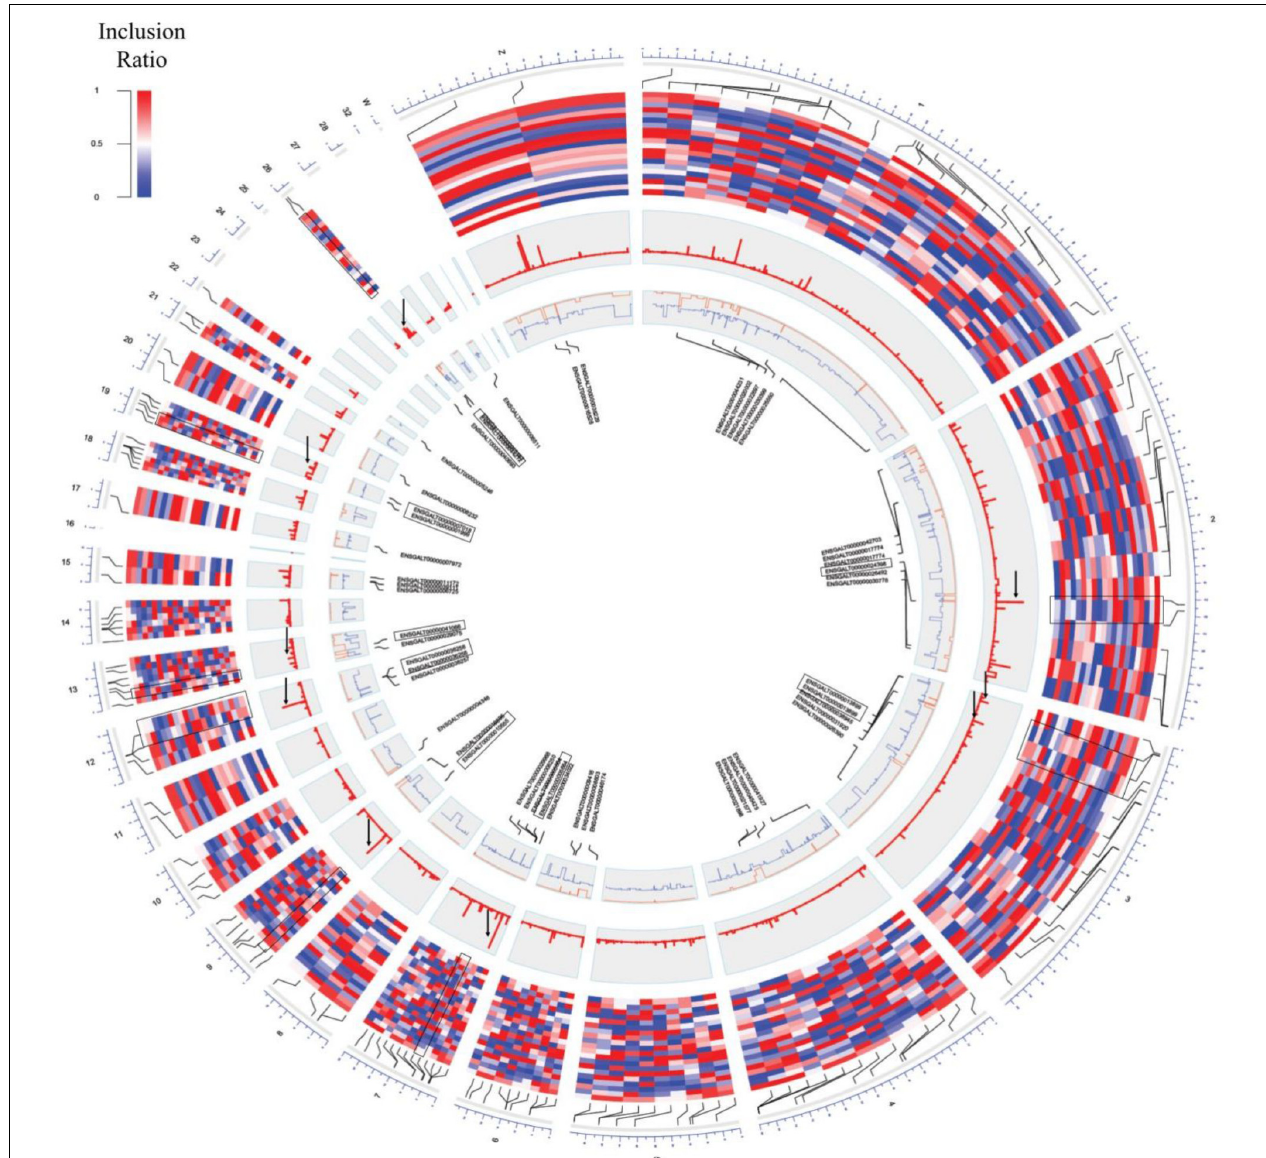
FIGURE 3 | Circos plot of switch-like exons. From the outer circle to inner circle are the genomic position, inclusion ratios, developmental stage, significance signal [–log( q -value)], inclusion ratios of the immature eggs and mature eggs (red: mature eggs, blue: immature eggs), and the gene name of the significantly changed exons. The highlighted pairs are the genes that were converted and for which GO terms were found (black box). Significantly changed signals are marked with a black